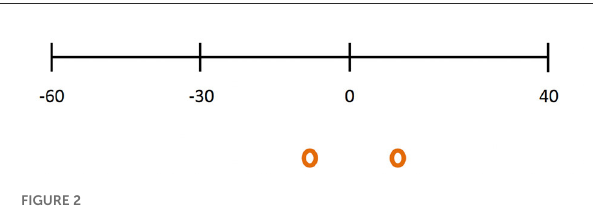
FIGURE2 Scheme of the spatial position of sources for the auditory representation of data. Numbers indicate the x-position (in centimeters) of the four represented sources on a horizontal axis centered in front of the user. The position of the ears (represented by the two red circles) is 10 cm for the left ear and +10 cm for the right one, and corresponds to the position of the headphones in which each source sound as a stereo signal. The stereo location of the sound corresponds to the actual location of the source on the